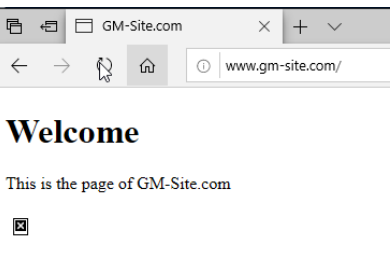
Figure 6. Failure to display image referenced by the “.html” file.